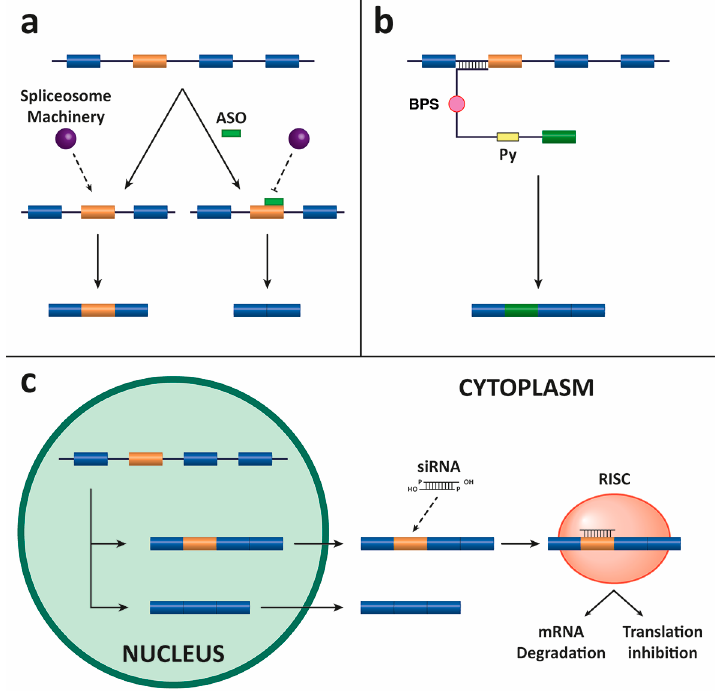
Figure 4. Three different strategies to target splicing for gene modification. ( a ) The diagram depicts an antisense oligonucleotide (ASO) ‐ based strategy to target an alternatively spliced exon (in orange). In the absence of the ASO, the spliceosome is assembled and the exon is included in the mRNA; in the presence of the ASO, the spliceosome is sterically blocked and the exon is skipped and not included in the mRNA. ( b ) SMaRT strategy for trans ‐ splicing by 5 ′ exon replacement. Schematic representation of the gene ‐ specific pre ‐ trans ‐ splicing molecule (PTM). The coding sequence of the PTM consists of an exon (in green), and the trans ‐ splicing domain of the PTM comprises a binding ‐ domain (BD) complementary to the 3 ′ end of the gene intron as well as highly conserved BPS and Py sequences. ( c ) Illustration depicting the mechanism by which siRNA can inhibit the expression of specific exon ‐ containing target gene products by hybridizing to the mRNA and triggering RISC ‐ mediated degradation or translational inhibition.